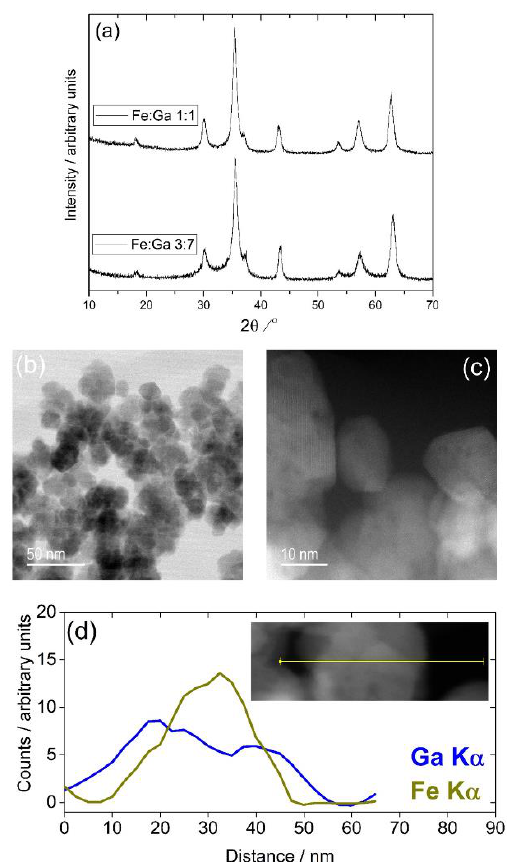
Figure 5. ( a ) Powder XRD of two samples of Fe-substituted Ga 2 O 3 with different Fe:Ga ratios; ( b , c ) HR-TEM of the 3:7 Fe:Ga ratio material and ( d ) EDS line-scan of a region of the 3:7 Fe:Ga sample showing local